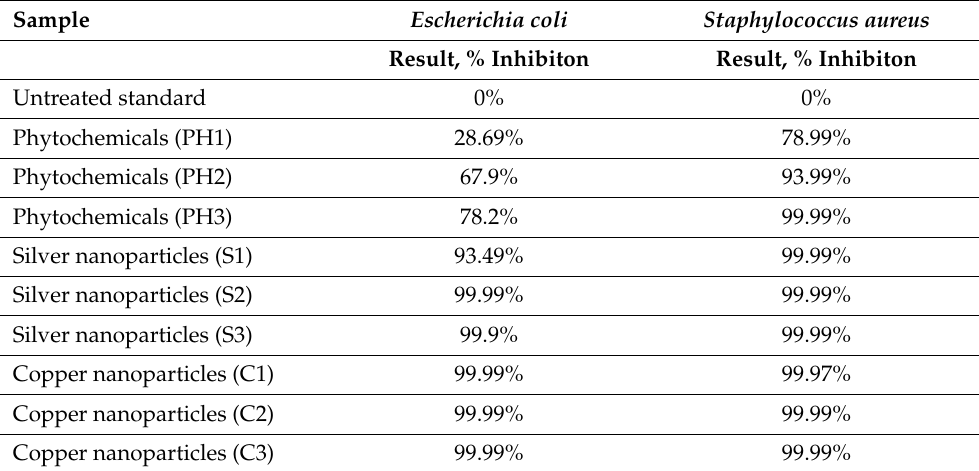
Figure 14. Antibacterial activity in terms of log CFU/mL ( left ) and percentage reduction ( right ) of fabrics treated with phytochemicals, silver, and copper nanoparticles and untreated cotton fabric. Table 5. Reduction percentage of untreated and treated cotton